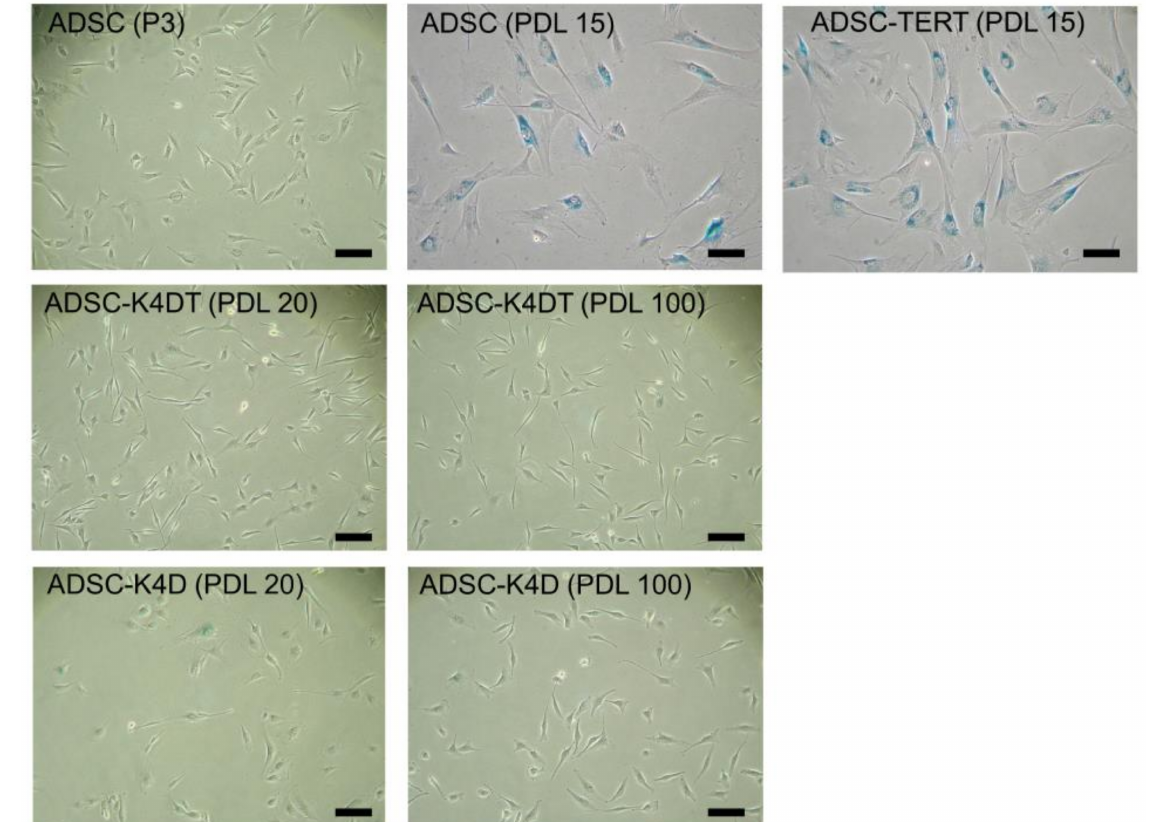
Figure 6. SA- β -gal expression in the primary ADSCs and ADSCs post-transduction. Senescence cells were not detected among the primary ADSCs at passage 3, but most of the primary ADSCs at PDL 15 (passage 7) were stained with SA- β -gal. The ADSC-TERT cells at PDL 15 had almost ceased proliferation and were identified as senescence cells similarly to the primary ADSCs at PDL 15. Few senescence cells were detected with SA- β -gal staining among the ADSC-K4DT and ADSC-K4D cells even at PDL 100. Bar = 100 µ